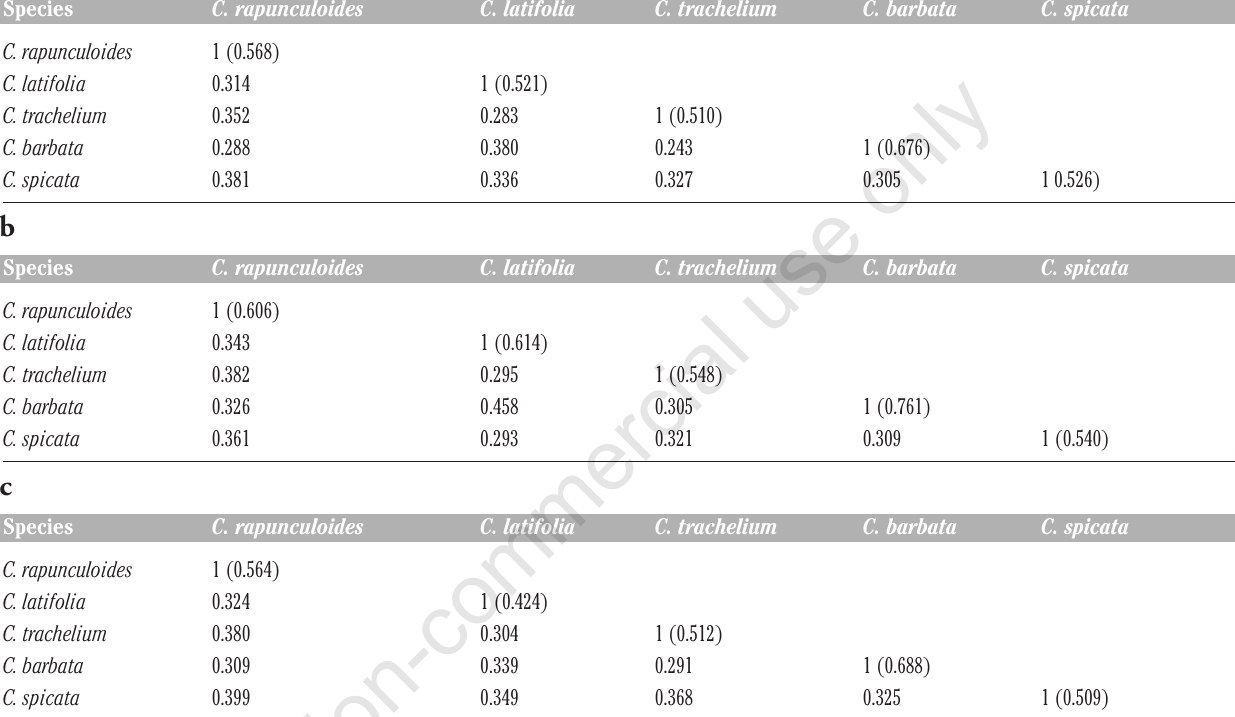
Table 3. Mean pairwise similarity matrix based on Nei and Li matrix between the five Campanula species performed on: (a) joined myb and NBS data, (b) myb data and (c) NBS data. In brackets the mean similarity values within the species. a Species C.